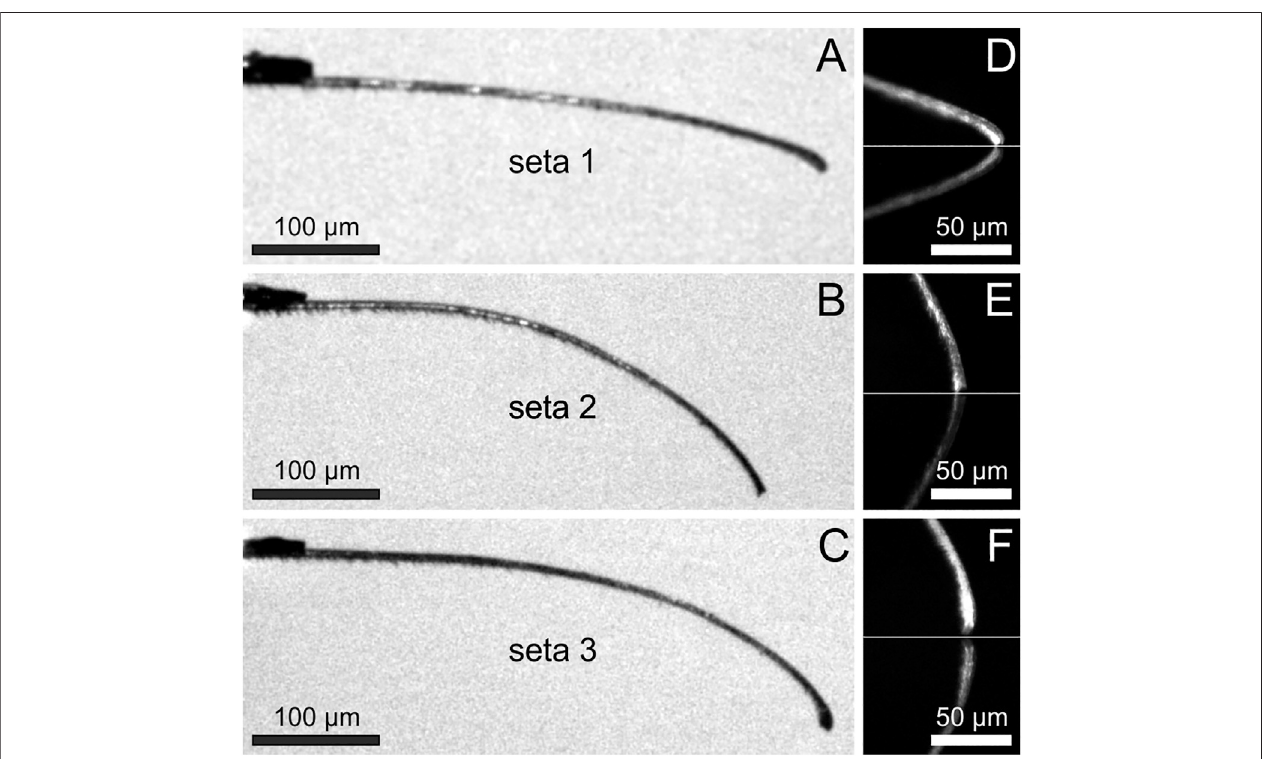
FIGURE 3 | (A – C) Individual adhesive setae in side view fi xed to the force sensing cantilevers (top left). Note the different curvatures and tip shapes of the setae takenrandomlyfromthecenterofthepretarsalscopula (D – F) Tipregionsofthesetaeshownin (A – C) adheringtoaglasssurface(markedbythewhitehorizontallines)at theanglesusedforthemeasurementsondifferentsubstrates. Belowthewhitelines,themirrorimagesofthesetaearevisible.Theanglesofthemostdistal20 µmofthe setae with the glass surface were measured to be 44.8 ° for seta 1, 85.1 ° for seta 2, and 88.4 ° for seta 3.